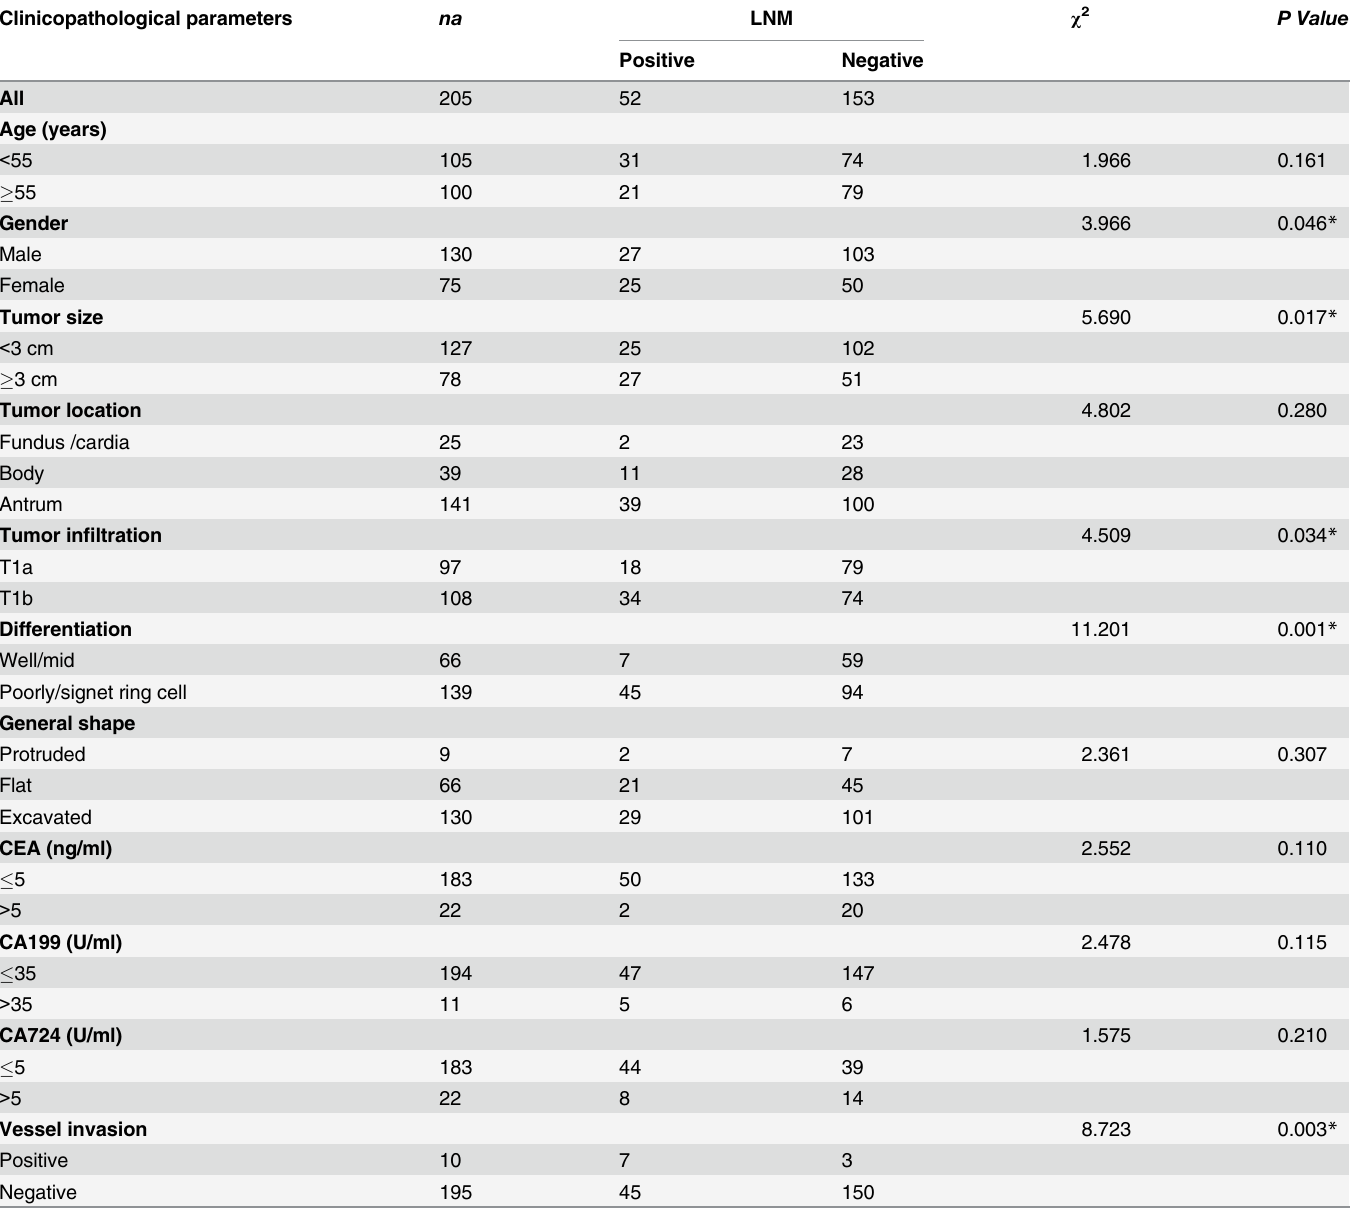
Table 1. Correlation between LNM and clinicopathological factors of 205 EGC